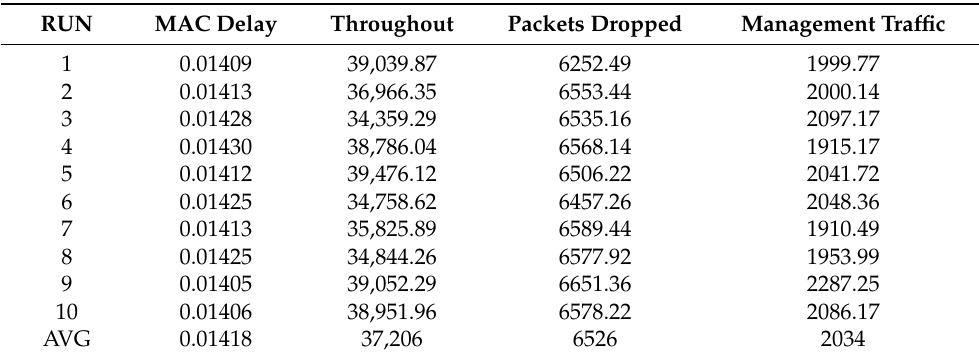
Table 6. Randomized Scenario Zigbee